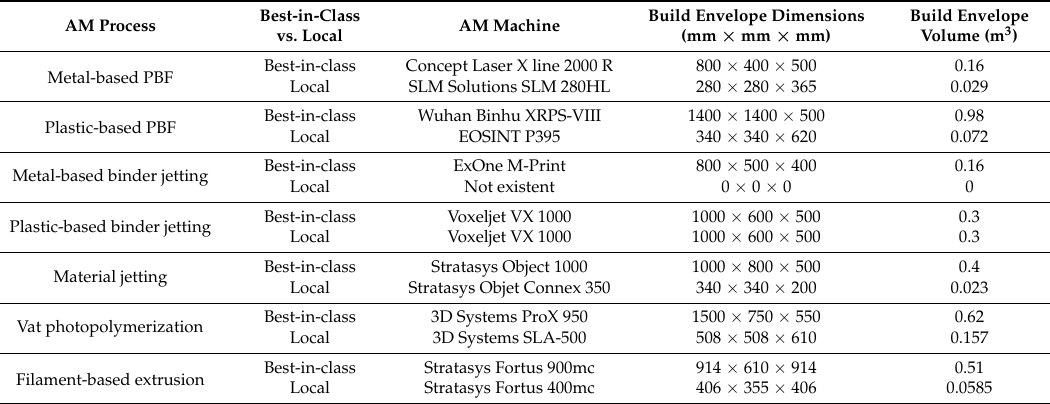
Table 4. Current maximum build envelopes (best-in-class and local) for relevant AM processes.